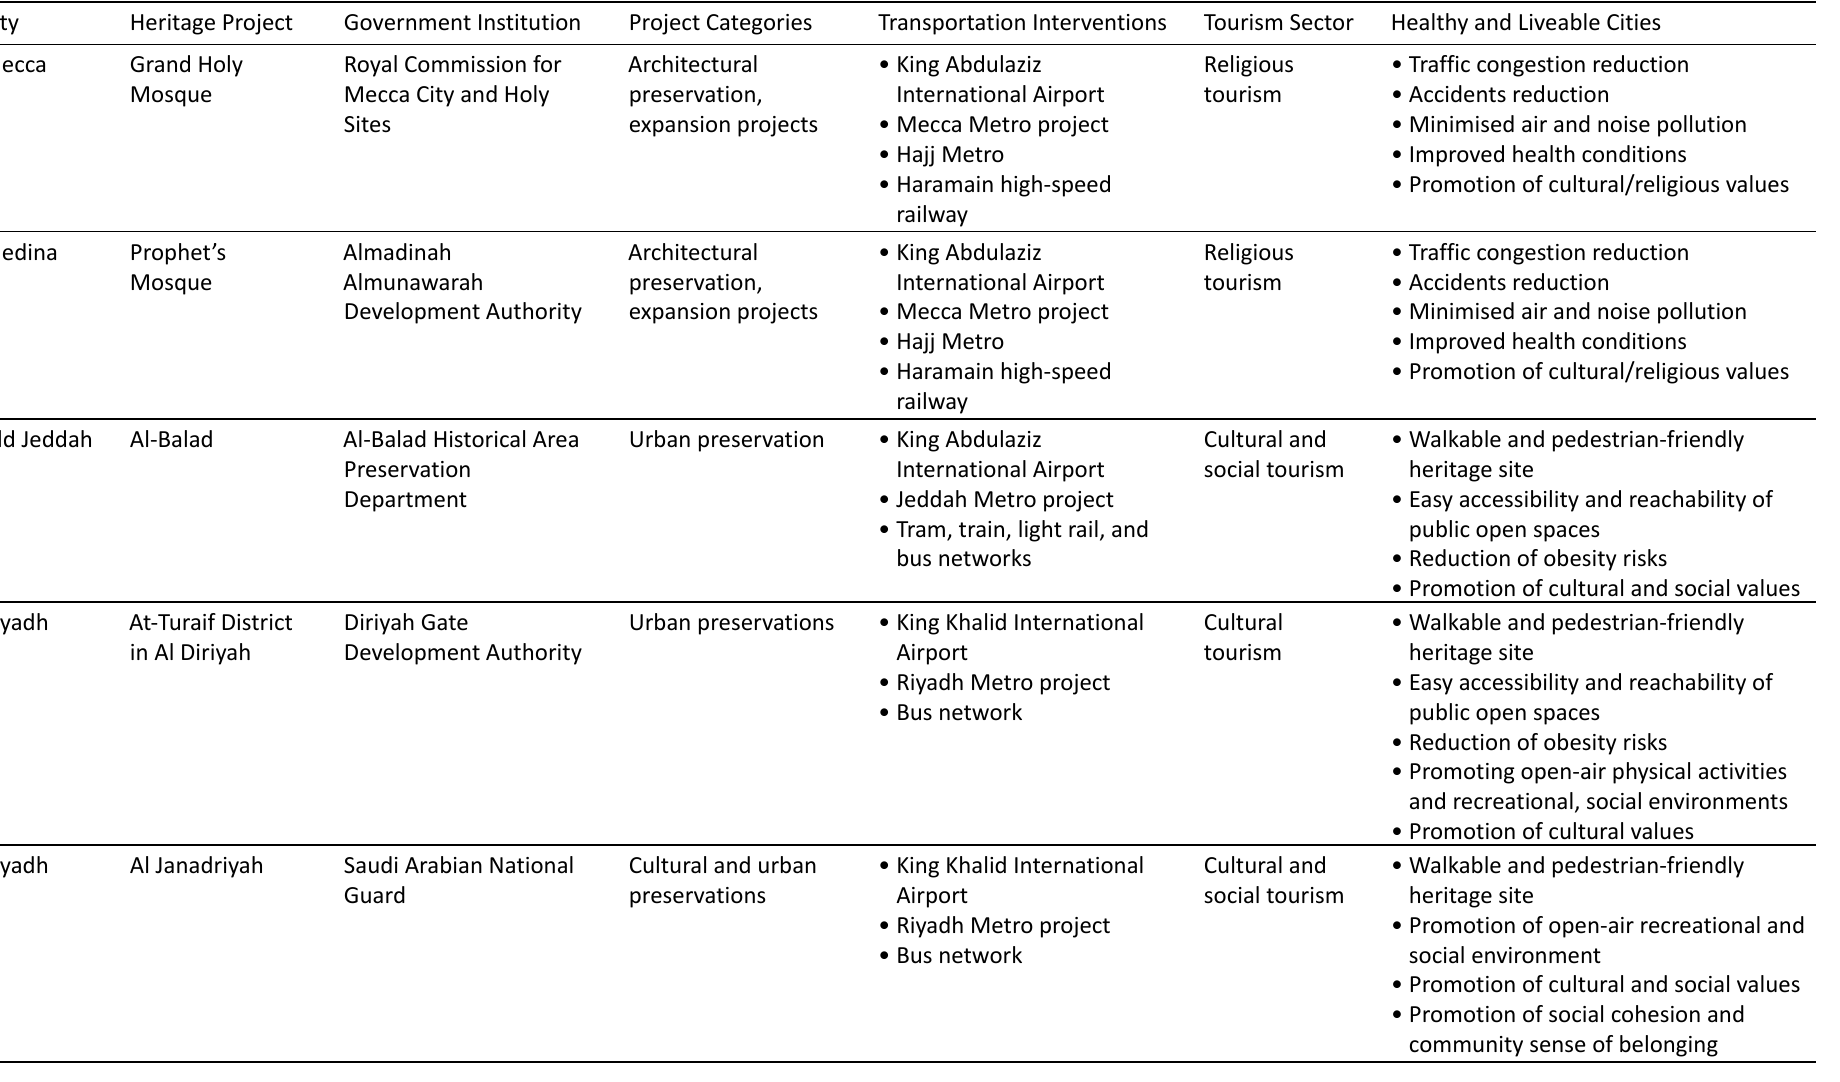
Table 1. Comparisons between the analysed heritage rehabilitation projects, showing the improvement of the transportation systems of the selected case studies and the enhancement of tourism